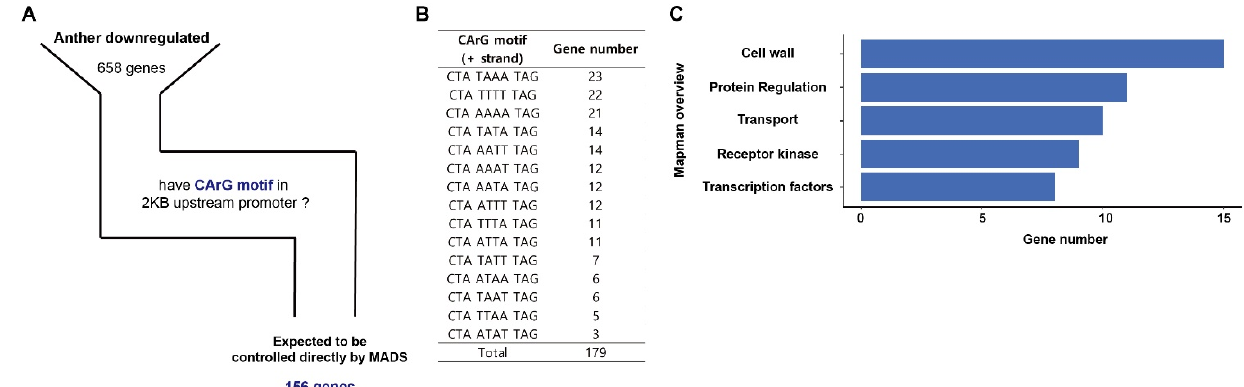
Figure 4. Screening and analyzing the CArG Cis-regulatory elements motif in the promoter of anther downregulated genes. ( A ) Of the 658 anther downregulated genes, 156 genes had CArG motifs in 2kb (2000 base-pair) upstream of the promoter regions. The upstream were numbered based on the adenine of the start codon. ( B ) Types and frequencies of CArG motifs existed in the promoter of anther downregulated genes. ( C ) MapMan enrichment analysis for 156 DEGs that had CArG motif in the promoter region. The x-axis means gene number, and the y-axis represents the type of overview registered in